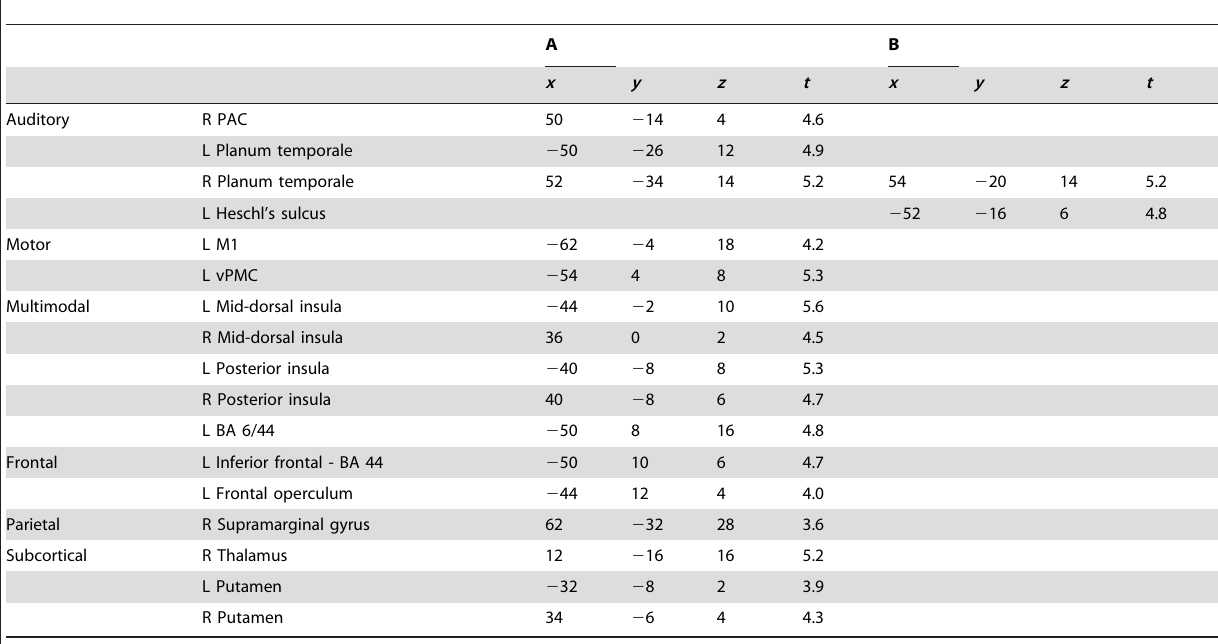
A: Brain regions whose activity significantly correlated to activity within right planum temporale (52, 2 20, 6) prior to micromelody discrimination training. B: Brain regions displaying stronger connectivity with the right planum temporale (during simple singing) after auditory training compared to before training. All peak/ cluster p s # 0.05, corrected. BA = Brodmann area; BA 6/44 = ventral premotor cortex and inferior frontal gyrus, pars opercularis; M1 = primary motor cortex; PAC = primary auditory cortex; vPMC = ventral premotor